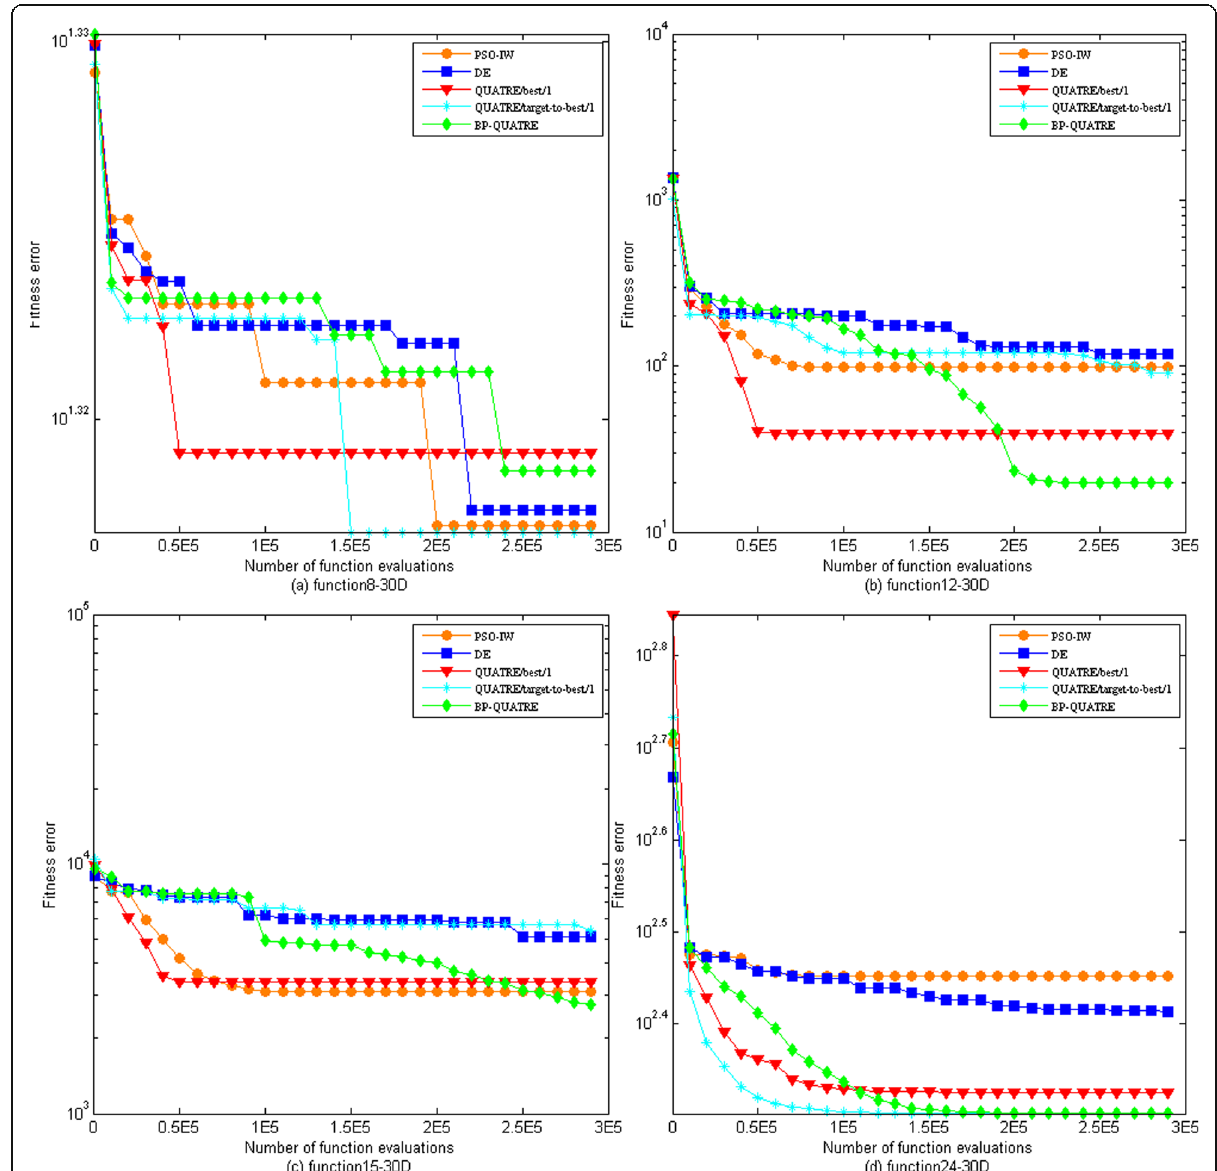
Fig. 2 Fitness errors vs. number of function evaluations of functions f8, f12, f15, and f24. The figure presents the fitness error and the convergence speed comparison by employing the best value of 50 runs obtained by each competing algorithm on 30-D optimization. The functions f8, f12, f15, and f24 figures are presented here. NFE means number of function